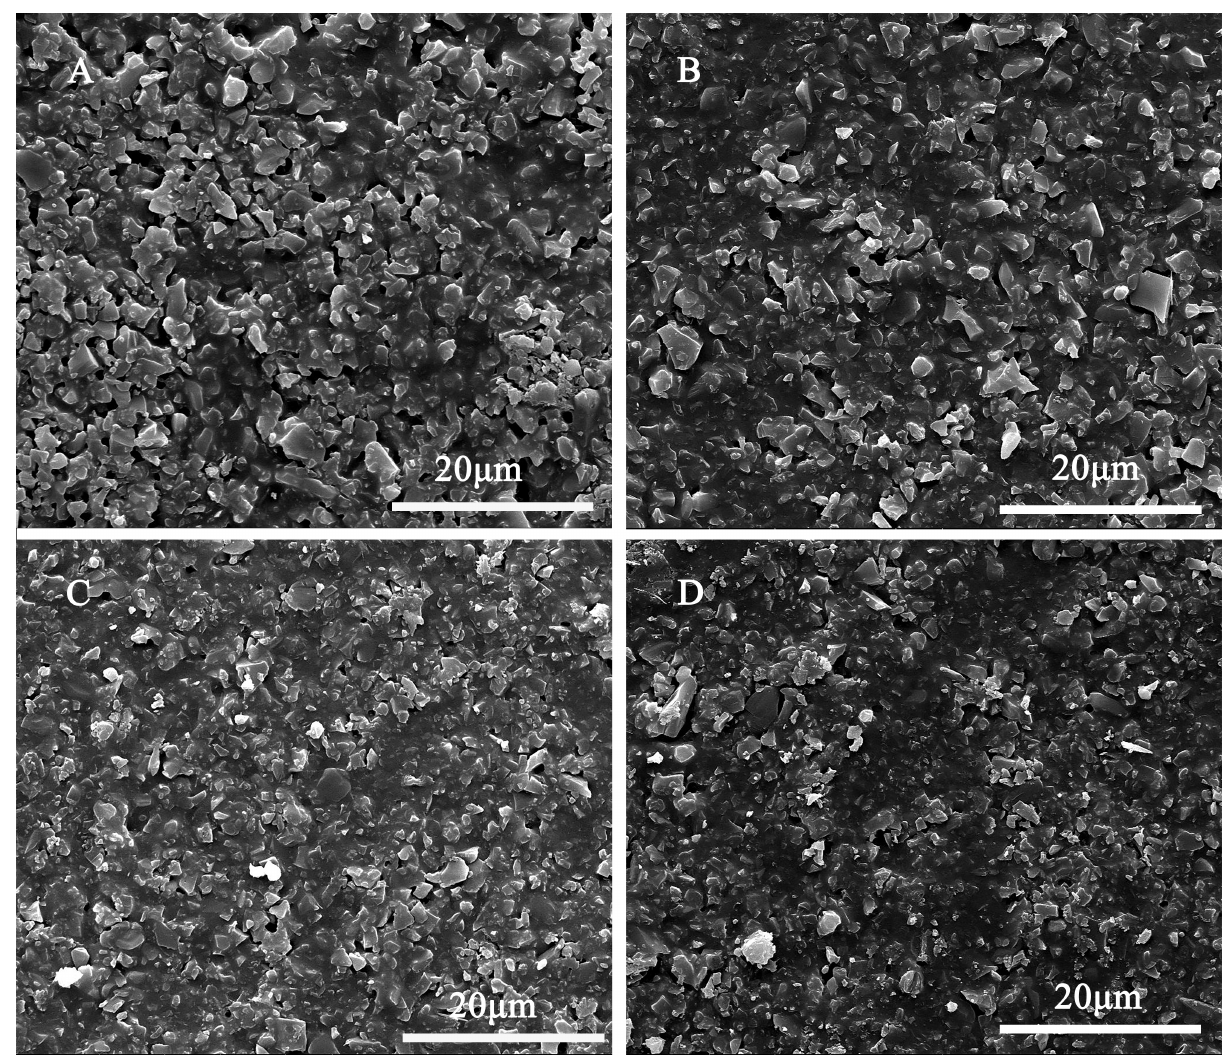
Figure 3: SEM micrograph of composites measured by secondary electrons mode A) S1; B) S4; C) S8; D)